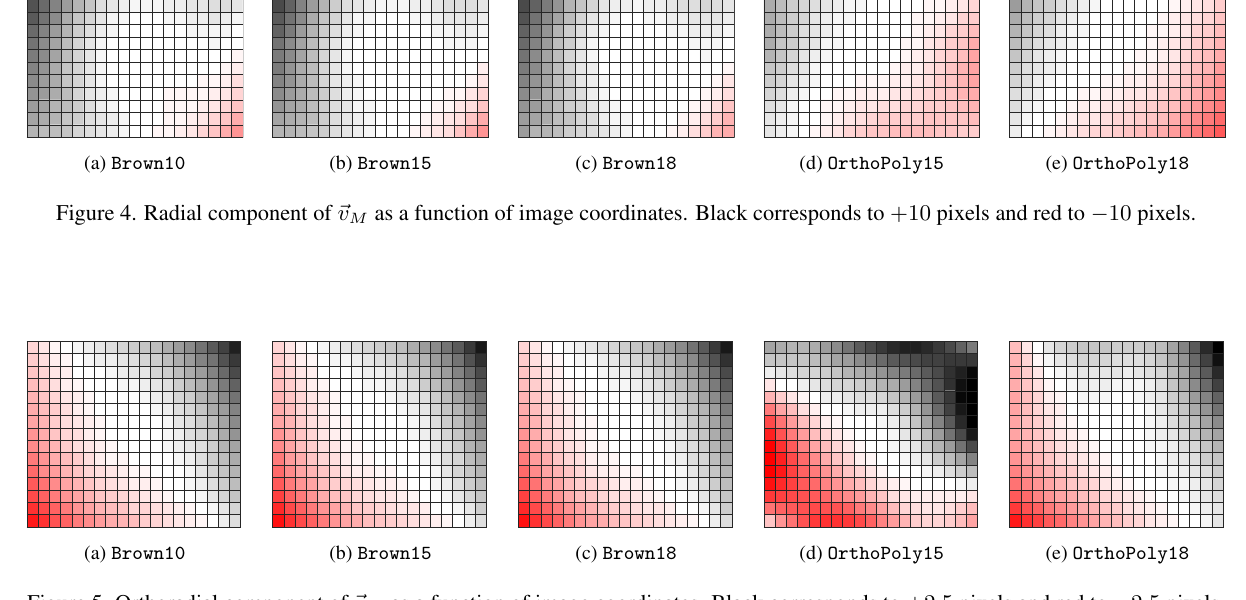
Figure 5. Orthoradial component of (cid:126)v M as a function of image coordinates. Black corresponds to +2 . 5 pixels and red to − 2 . 5